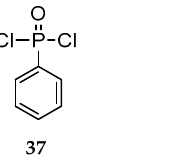
Figure 15. Phosphine oxide derivative 38 and its precursor 37 .